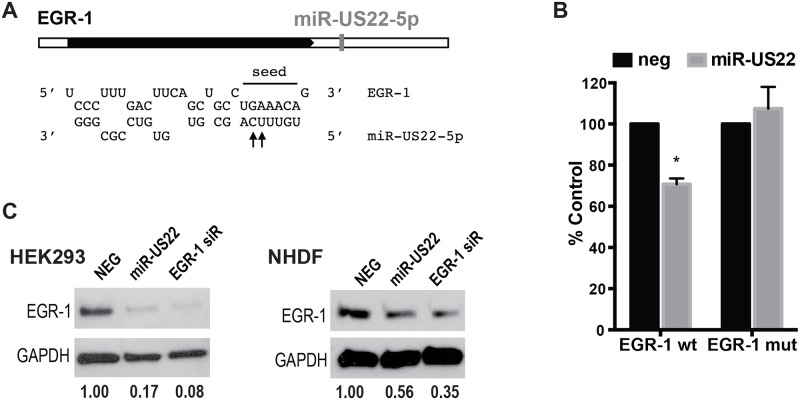
EGR-1 3’UTR is targeted by HCMV miR-US22.(A) One miR-US22 target site is present in the EGR-1 3’UTR. The seed sequence is indicated; the arrows label the bases that were mutated to disrupt miR-US22 binding to the target site. (B) The miR-US22 target site is required for EGR-1 down-regulation. Dual luciferase reporter containing EGR-1 3’UTR with wild type target site or mutated target site were co-transfected with the indicated mimics, and assessed for luciferase expression 24 hours later. Data graphed as mean ± SD from 3 independent experiments; * p = 0.005 compared to NEG—transfected cells (unpaired t test). (C) HEK293 or NHDF cells were transfected with NEG siRNA control, miR-US22 mimic, or EGR-1 siRNA for 48 hours, after which the cells were serum starved (4 hours), treated with 50ng/mL EGF (1 hour), and harvested for immunoblot (IB) analysis. Protein concentrations were normalized to GAPDH, and relative levels are displayed.